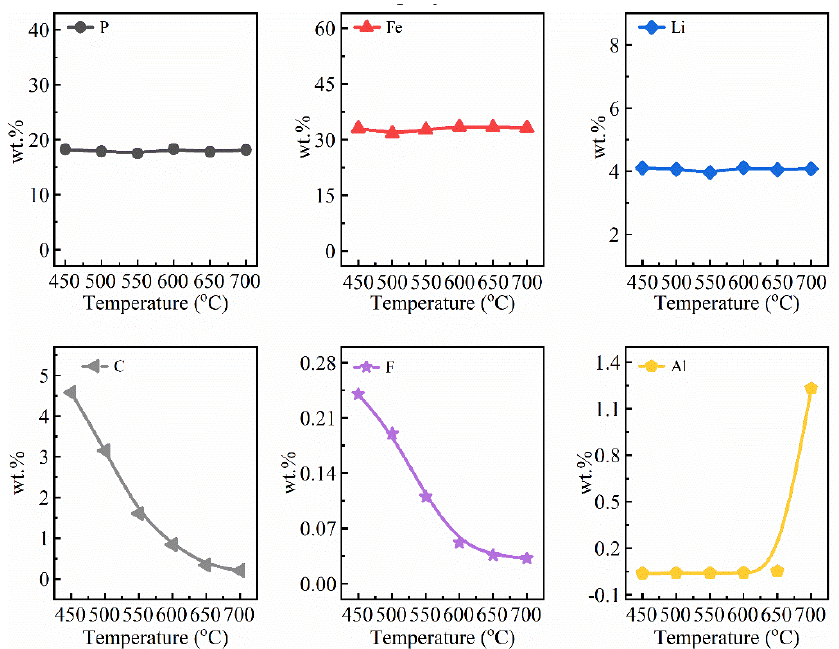
Figure A1. Chemical analysis of calcined cathode materials obtained at di ff erent roasting